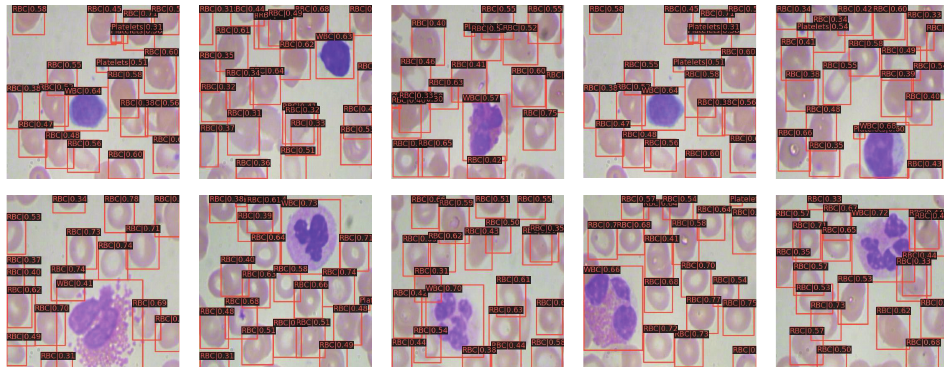
Figure 3. Visualization detection results on BCCD test dataset.